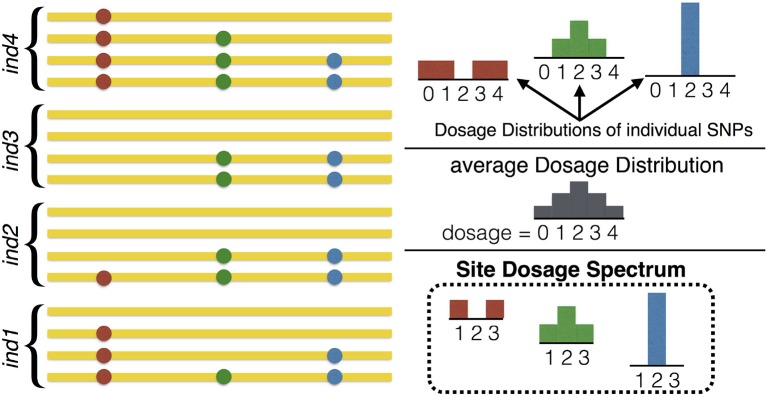
Illustration of the relation between the Dosage Distribution and the Site Dosage Spectrum. On the left, homologous sequences from 4 tetraploid individuals are shown (n = 4, p = 4), containing 3 SNPs of frequency 50%. On the right, the three DDs (one for each SNP) are shown at the top. The SDS at the bottom is the distribution of these DDs (which in this example is given by the three DDs with probability 1/3 each). Note that the SDS bears no relation with the average DD, which is shown in the middle. In this example, the Site Frequency/Dosage Spectrum would be ψ8, {1/4, 0, 1/4} = 1/3, ψ8, {1/4, 1/2, 1/4} = 1/3, ψ8, {0, 1, 0} = 1/3 and ψ8,{I}=0 for other choices of I.